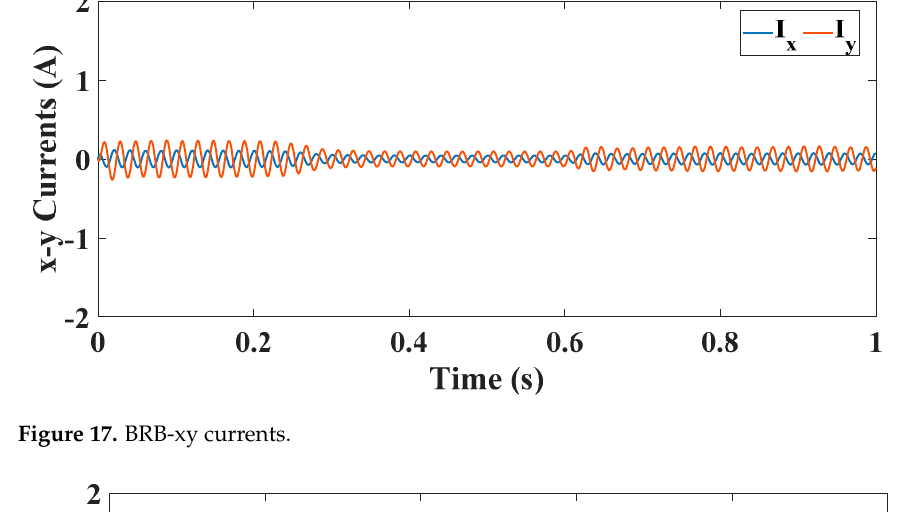
Figure 16. BRB- αβ currents.